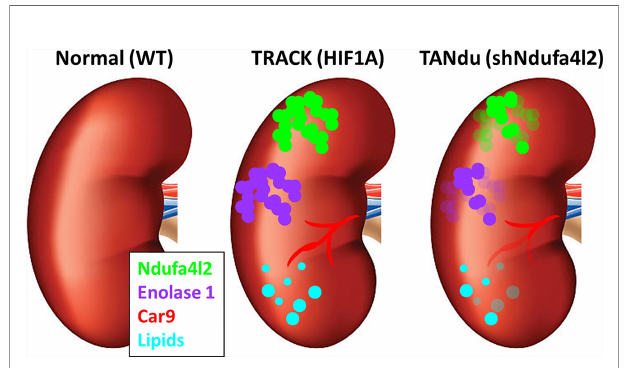
FIGURE 5 | Summary of the effects of Ndufa4l2. In contrast to normal kidneys, TRACK kidneys exhibit lipid accumulation (cyan), and are positive for Ndufa4l2 (green), Enolase1 (purple), and Car9 (red). In the TANdu kidneys, the decreased level of Ndufa4l2 protein (relative to TRACK kidneys) is accompanied by decreased levels of Eno1 and Car9, and reduced lipid accumulation, suggesting that decreasing the levels of Ndufa4l2 lessens the ccRCC